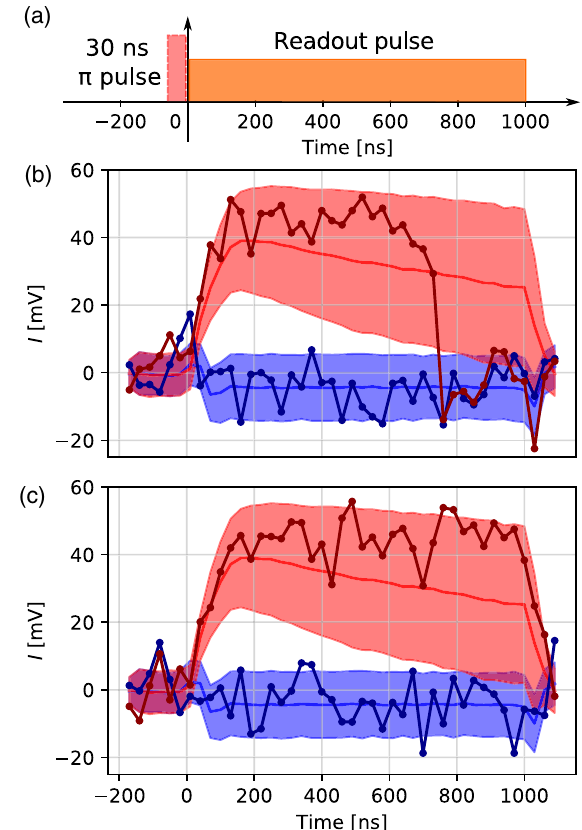
FIG. 4. Typical individual measurement records as a function of time, using the pulse sequence sketched in (a). We show typical quantum trajectories of the qubit in the presence (b) and absence (c) of a quantum jump. Blue and red points refer to the case the qubit is initially prepared in states j g i and j e i , respectively 2 starts at t ¼ ( t ¼ 0 ). The readout pulse with amplitude ¯ n l ¼ 0 ns and stops at t ¼ 1000 ns. Each point is measured with a 30-ns integration, corresponding to the resonator rising time 2 κ − 1 . An average over 1000 measurement records is plotted in l solid blue and red lines, as well as their standard deviation represented by corresponding shaded